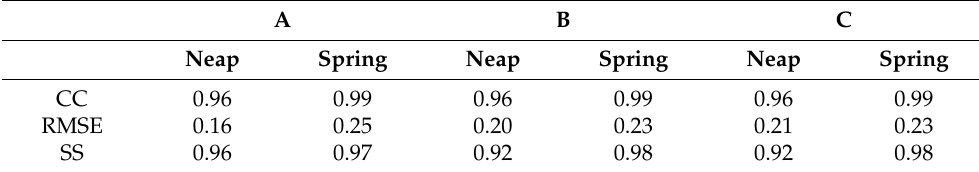
Table 1. CCs, RMSEs and SSs of the elevation at measurement sites A, B and C.